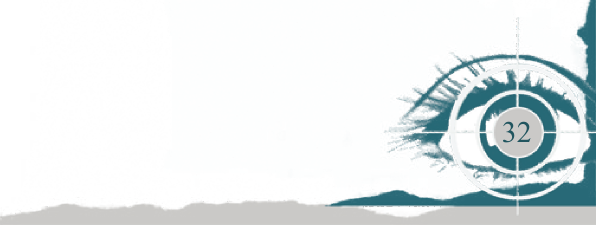
Figure 1. Comparison of percentage prevalence of visual acuity in dyslexic and control groups. Compared to the other acuity lev - els, the distribution of VA 6/6 (68%) was the highest in both groups followed by VA < 6/9